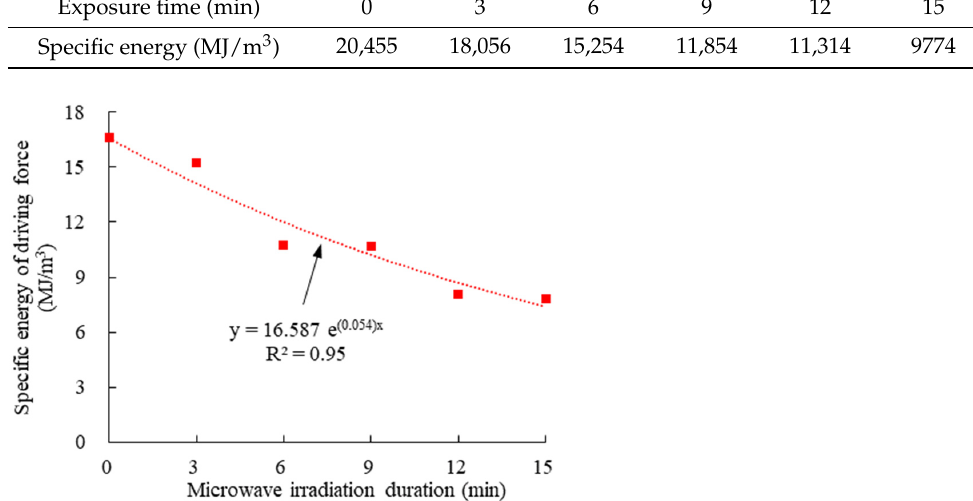
Figure 16. Relationship between the speci fi c energy of the rolling force and the microwave exposure time . 4. Discussion In this paper, a low-power multimode cavity microwave oven is used in the micro- wave heating test, and a reduced-scale TBM cu tt er is used in the cu tt er cu tt ing rock break- ing test. In practical engineering applications, because of the limitation of the microwave cavity, the cavity equipment cannot be directly applied to the engineering site. In order to realize the engineering application of microwave-assisted TBM cu tt er rock breaking, the open-type microwave cracking device of hard rock should be adopted. As for energy consumption, some scholars have analyzed the energy consumption of indoor microwave-assisted rock breaking [30]. For the actual fi eld application, the energy consumption is complicated, and it should be analyzed according to the actual situation of the fi eld. Regarding the construction process, two construction methods can be pro- posed based on actual geological conditions. One is to apply microwave radiation and cu tt er action concurrently if the rock mass is readily fractured. The other is to irradiate the rock mass to prefracture it and then use the TBM cu tt er head to cut the rock. Apart from these, technical issues such as the power and water supply, dustproo fi ng, shockproo fi ng, and equipment stability also need to be considered. If necessary, the structural fabrication of the TBM cu tt er head also requires modi fi cation.